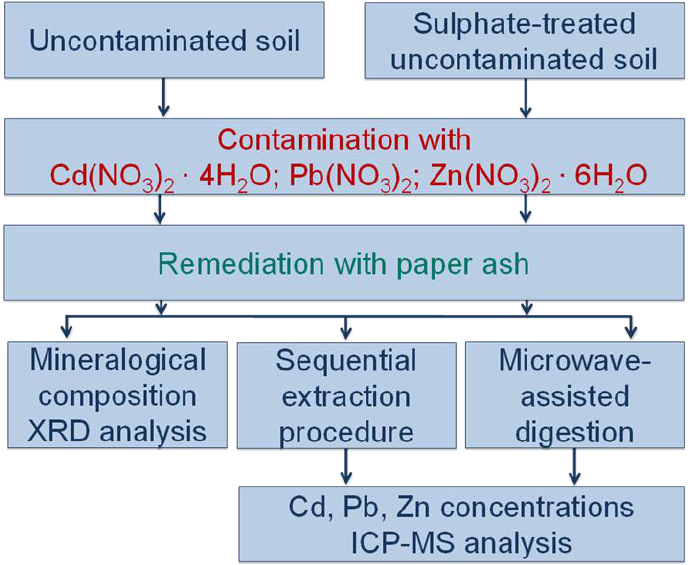
Figure 1. Flow chart of the experimental design.